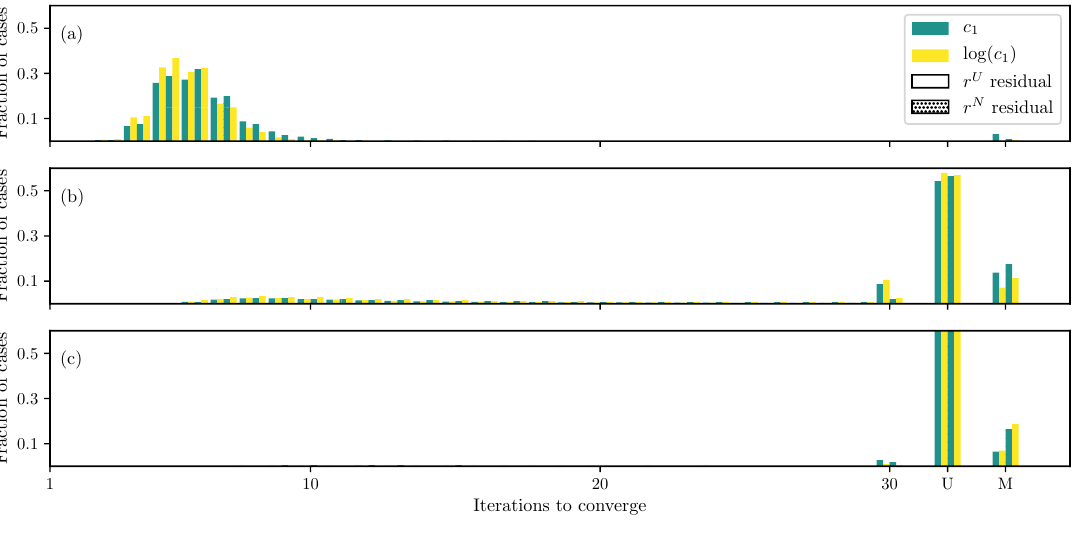
Figure 7. Iterations required using different formulations for the Lee–Sacks model FC case when ( a ) only c 1 and c 2 are unknown, ( b ) all parameters except the fiber angle θ are unknown, and ( c ) all parameters are